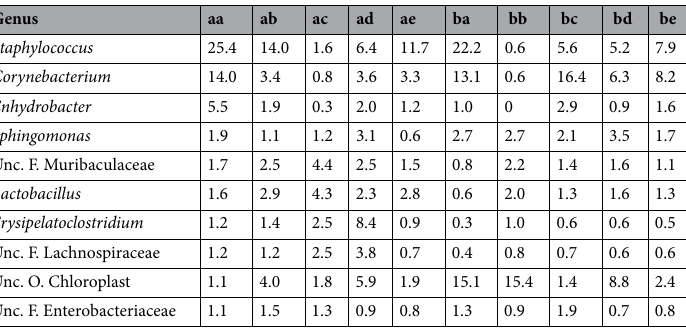
sis showed that there were 226 taxa in all samples at the genus level, accounting for 30.3% of the total 746 genera (Fig. 3a). A KRONA species note diagram is further shown in detail (Fig. 3b). The relative abundance of Staphy-